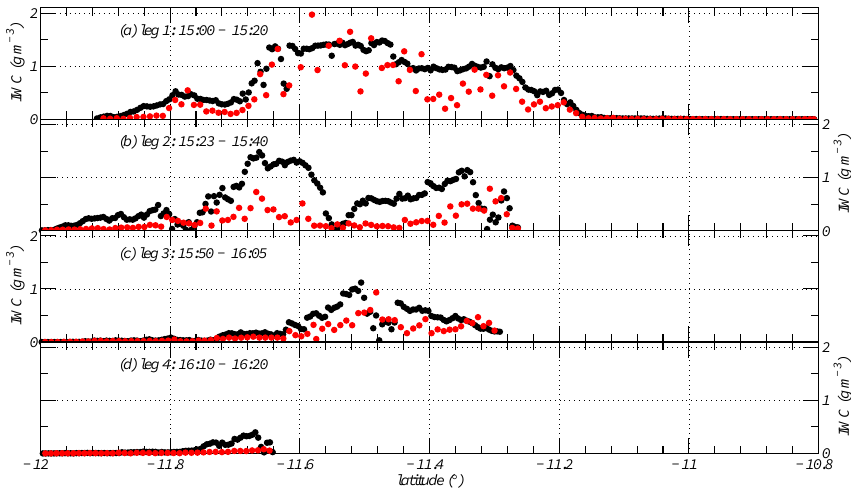
Fig. 5. IWC (gm − 3 ) determined by CIP (black) and CPI (red) across each flight leg 1–4, (a) – (d) as a function of increasing distance from the storm centre. There is a general decrease in IWC with distance as well significant lateral shift in core outflow. Note that the differences between the two probes arise because the CPI does not sample the large particles (due to poor sampling statistics) and the CIP does not sample the smaller particles (due to probe resolution).